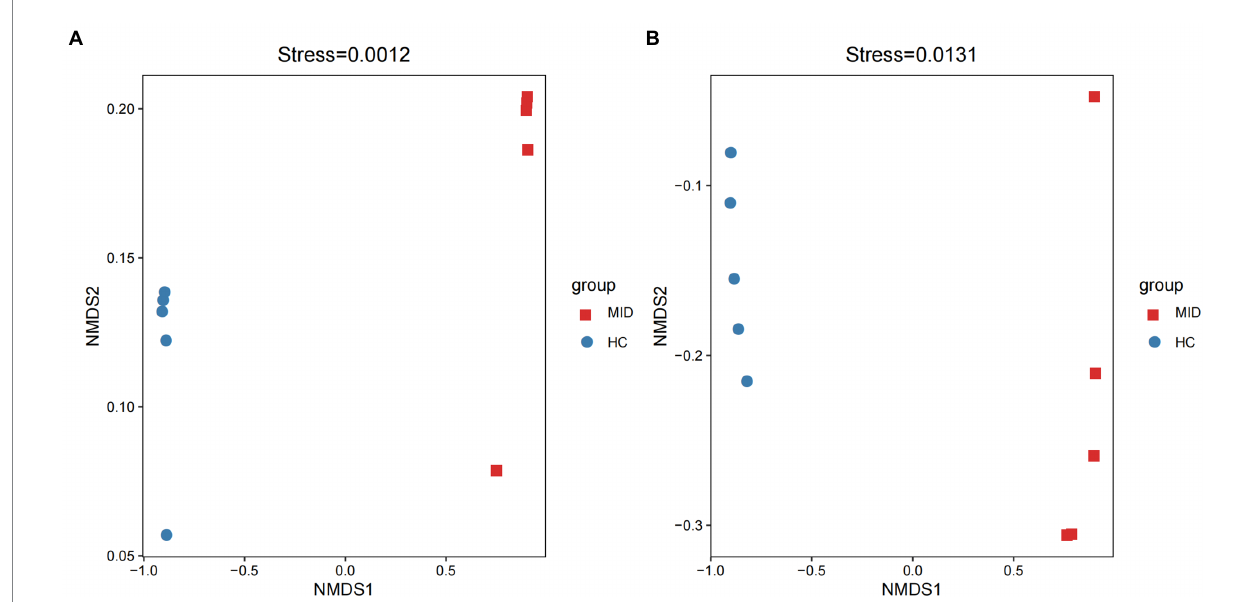
FIGURE 6 Non-metric multidimensional scaling (NMDS) of the microbial communities of different groups. Both gut (A) and oral (B) , all samples can be divided into two categories according to MID and HC.